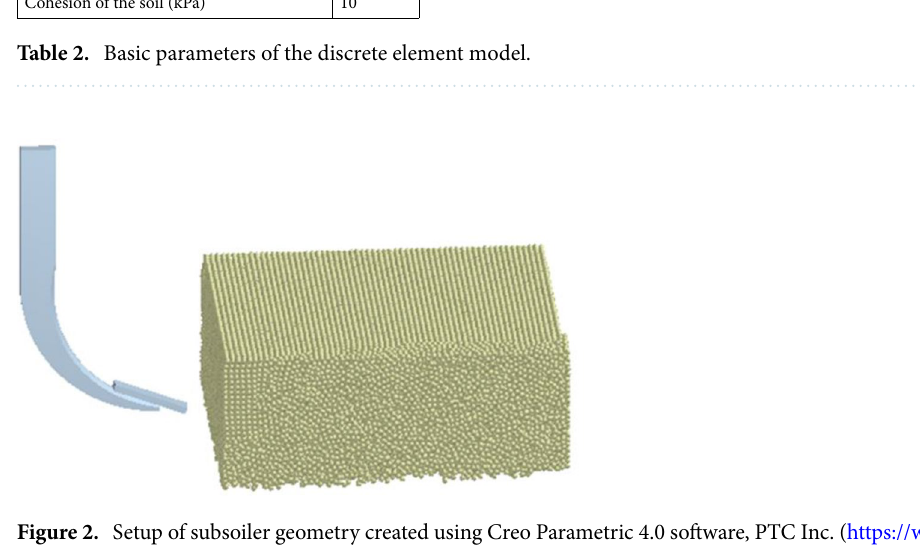
Figure 2. Setup of subsoiler geometry created using Creo Parametric 4.0 software, PTC Inc. (https:// www. ptc. com) and the virtual soil bin created using EDEM 2018 software, DEM Solutions Ltd. (https:// www. edems imula tion. com/ softw